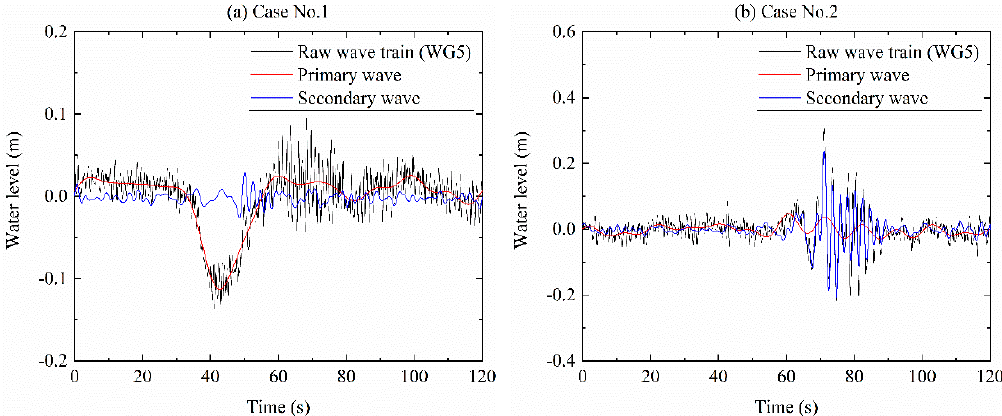
Figure 3. Typical raw wave structures and the filtered primary and secondary waves during the passages of ( a ) Case No.1 and ( b ) Case